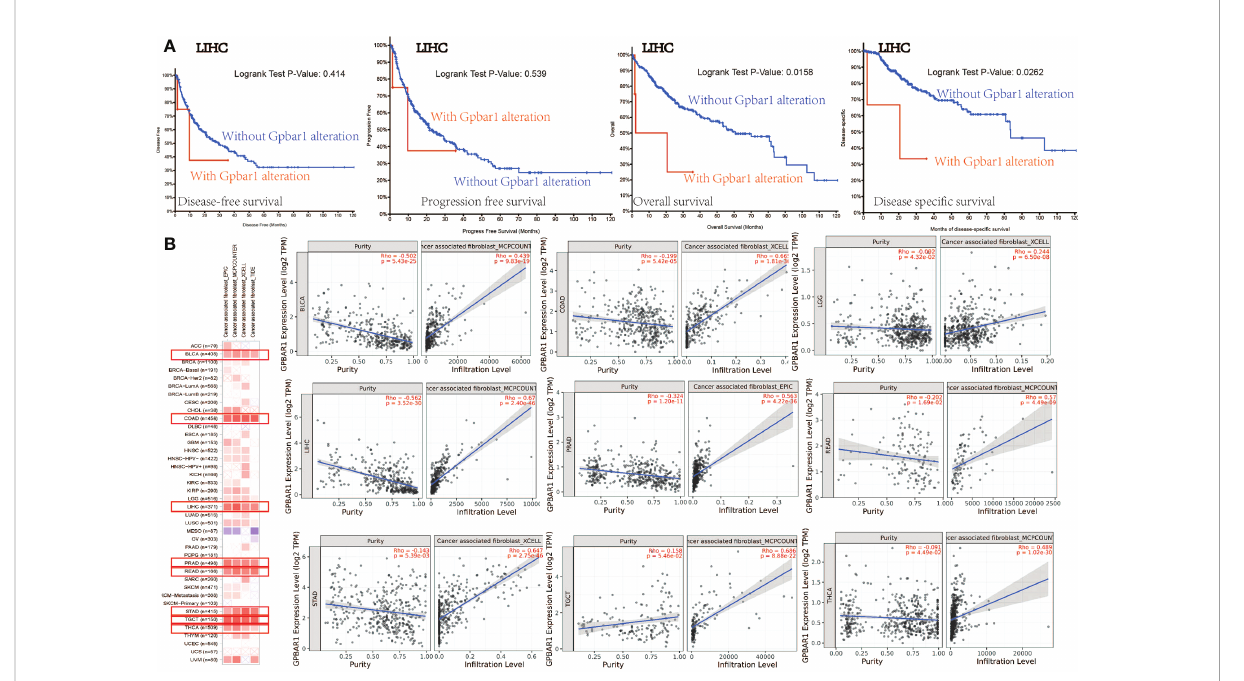
FIGURE 6 The mutation status with survival analysis and cancer-related fi broblast with TGR5 gene expression. (A) Use the cBioPortal tool to analyze the correlation between mutation status and OS (overall survival), DSS (disease-speci fi c survival), DFS (disease-free survival), and PFS (progression- free survival). (B) A correlation analysis between TGR5 gene expression and cancer-related fi broblast, which include EPIC, MCPCOUNTER, XCELL, and TIDE across all TCGA tumors. Red means positive correlation (0 – 1), blue means negative correlation ( − 1 to 0). A value of p < 0.05 is considered statistically signi fi cant. Correlation values that are not statistically signi fi cant are indicated by